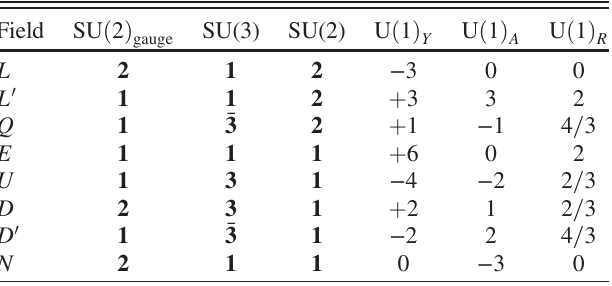
TABLE IV. Quantum numbers of the extended supersymmetric standard